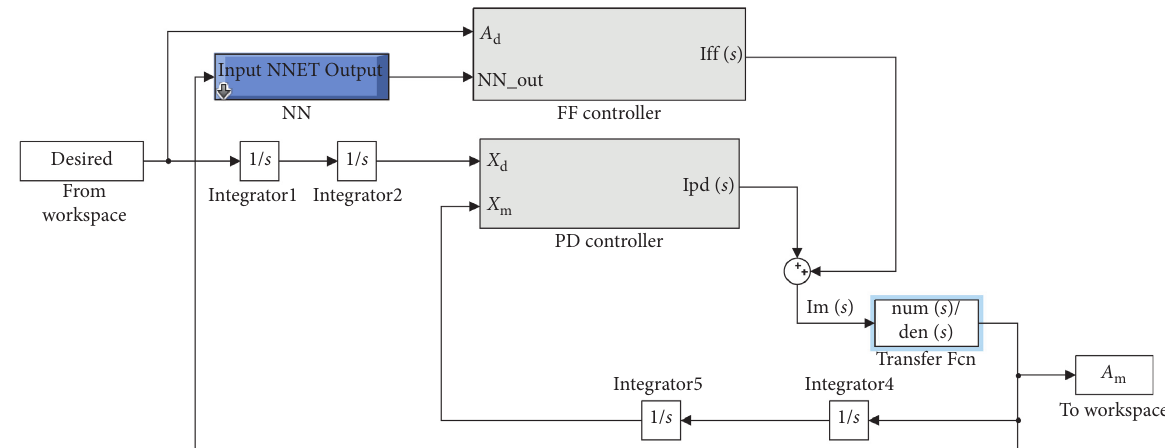
Figure 7: Combined NN-PDFF controller implementation on QUANSER